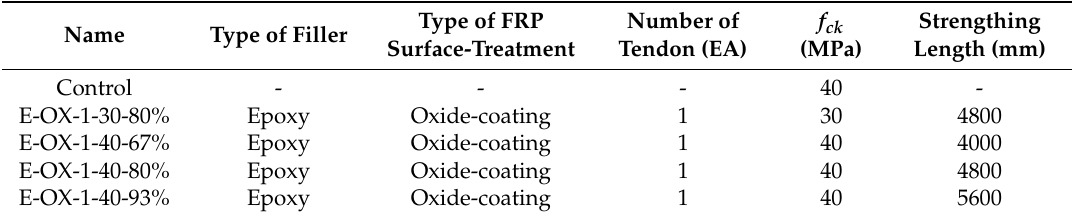
Table 1. Test variables and designation of specimens.